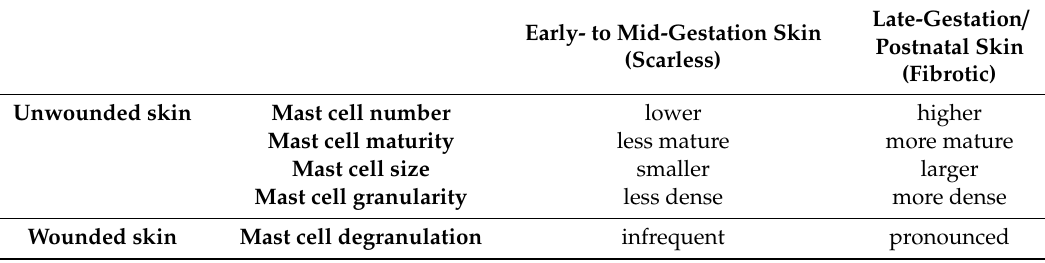
Table 1. Mast cell characteristics in developing